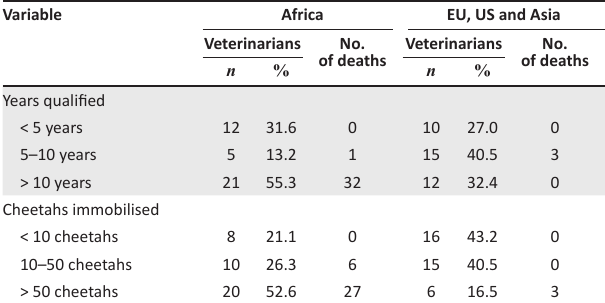
TABLE 1: Numbers (and percentages in each category) of surveyed veterinarians practising in African countries ( n = 38) and combined numbers in Europe, North America and Asia ( n = 37) in each time period since qualifying as a veterinarian (above) and in categories that reflect the number of cheetahs immobilised during their careers (below), as well as the total number of deaths reported in each